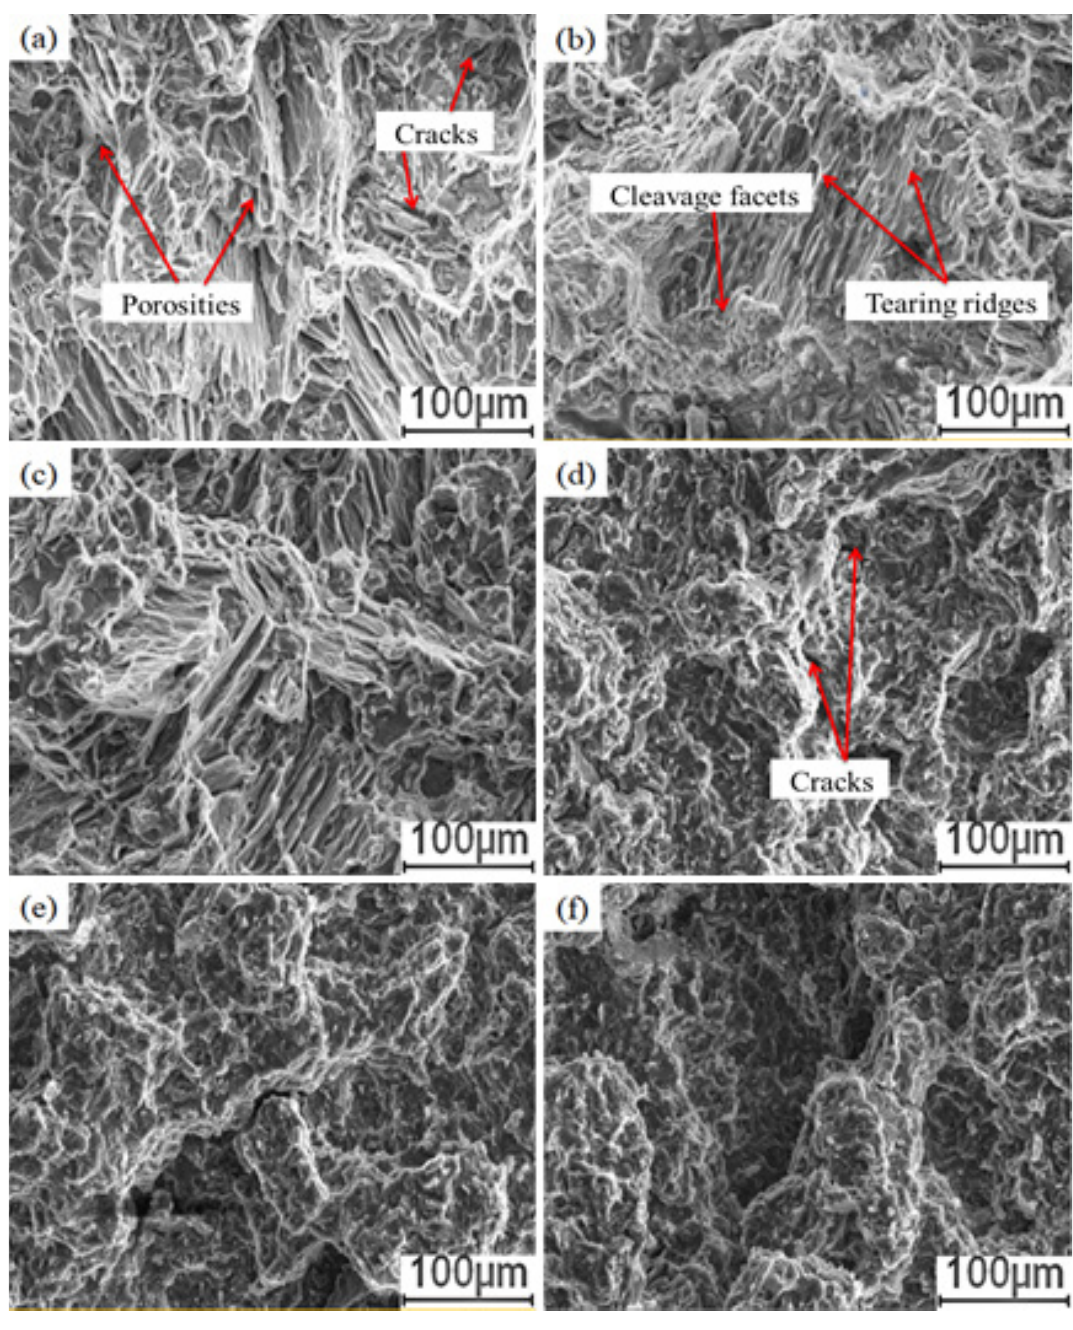
Figure 6 - SEM fractographs acquired from the investigated alloys (a) ZA120 alloy; (b) ZA122 alloy; (c) ZA124 alloy; (d) ZA126; (e) ZA128; (f)